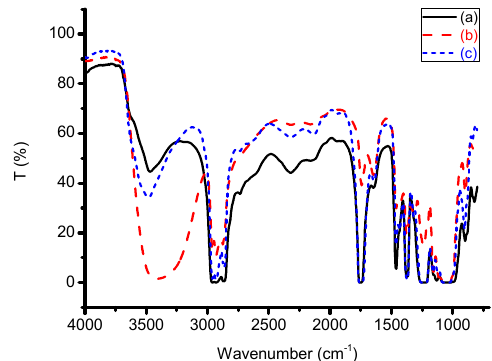
Figure 5. FTIR ‐ spectra of the membranes before and after the contact with the liquid in the strip cell. ( a ) before the permeation experiment; ( b ) conventional PIM scheme with 5 M HCl as the strip solution, after 20 h of permeation experiment; ( c ) PIMSD scheme with 5 M HCl as the strip solution, after 20 h of permeation experiment.